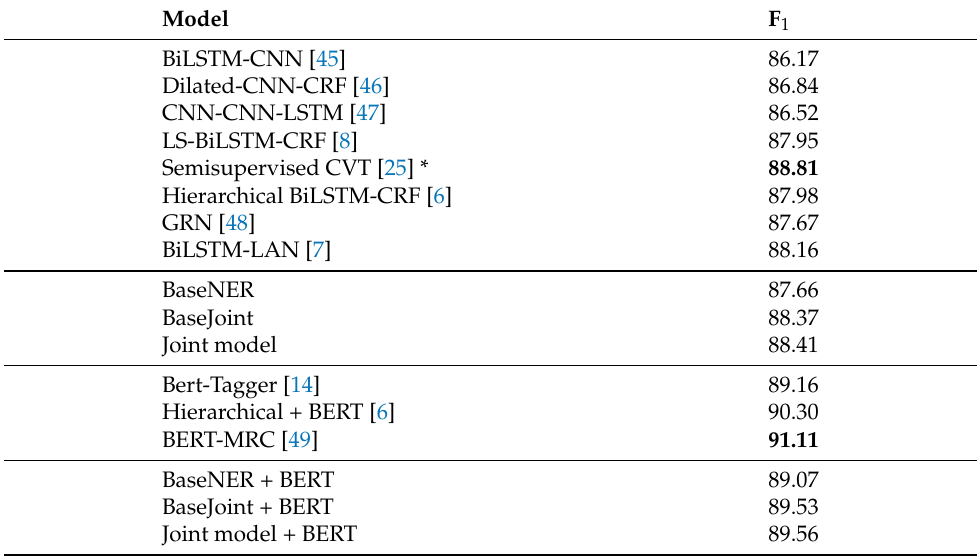
Table 4. F 1 -scores on the OntoNotes 5.0 test set. * denotes semisupervised and multitask